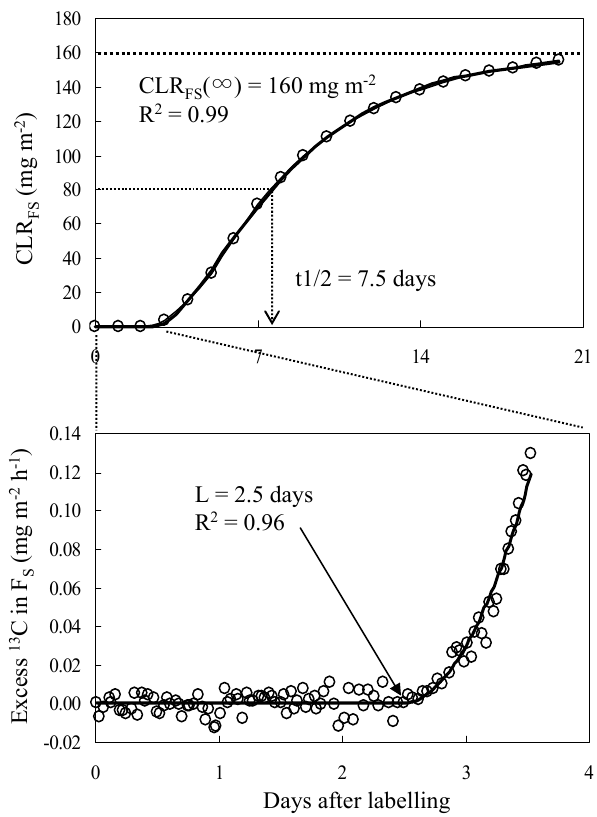
Fig. 1. Kinetics of cumulative excess 13 C in soil CO 2 efflux (CLR FS , top panel) and kinetics of excess 13 C in soil CO 2 efflux (Excess 13 C in F S ) . Open circles are measured data and the curves represent the best fits of Eqs. (9) and (11), respectively. The ex- ample shown is for pine labelled on 3 August 2009. Asymptotic value of CLR FS (CLR FS ( ∞ )) , half residence time of soil respired 13 C in the whole plant-soil system ( t 1/2) and time lag ( L ) between the start of the labelling and the first appearance of 13 C in soil CO 2 efflux are depicted on the graphs. In this example, the best-fitted rate constants are k CB1 = 0 . 022, k B1B2 = 0 . 001, k B2B1 = 0 . 130 and k B1A = 0 .